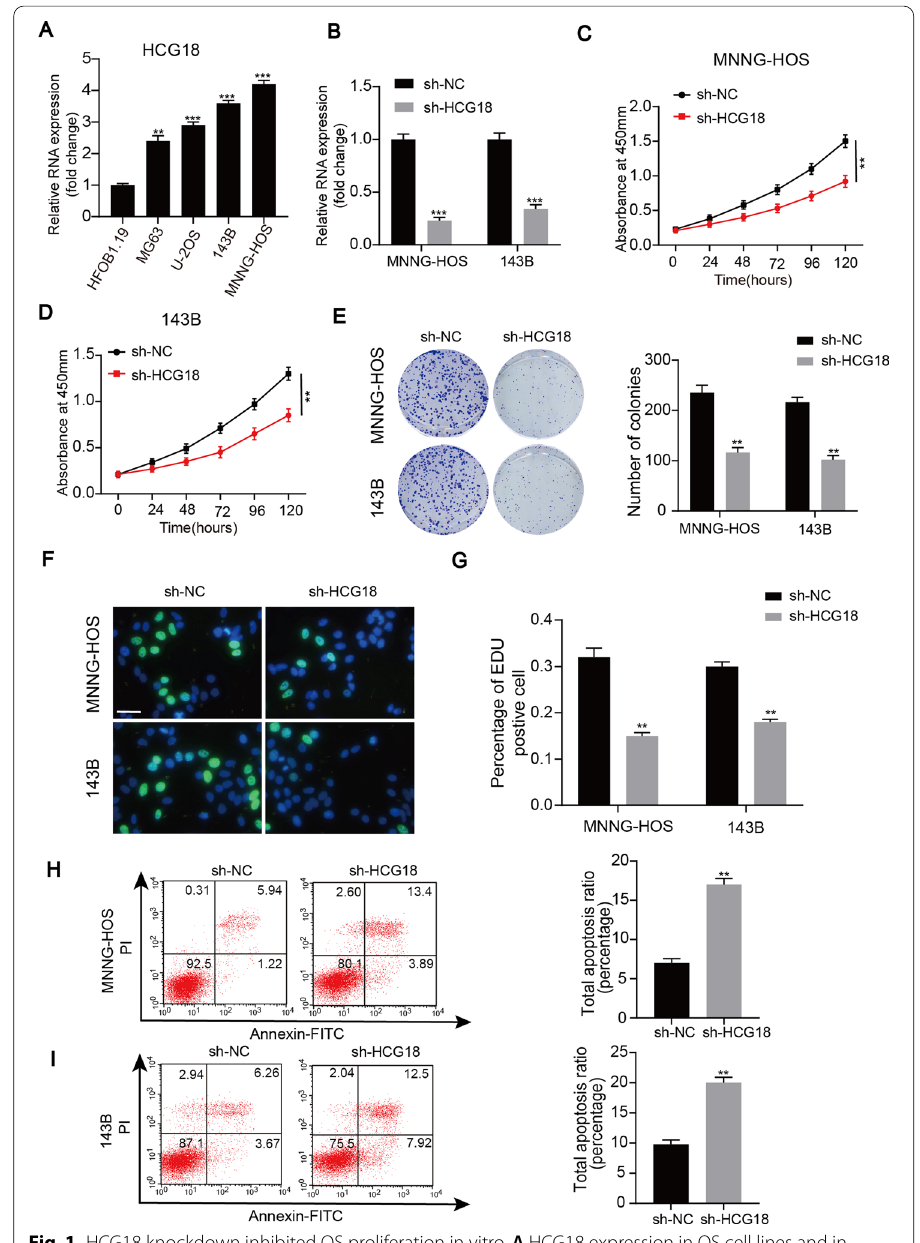
induces apoptosis of OS cells. ** represents P < 0.01, *** represents P < 0.001. All experiments were repeated three